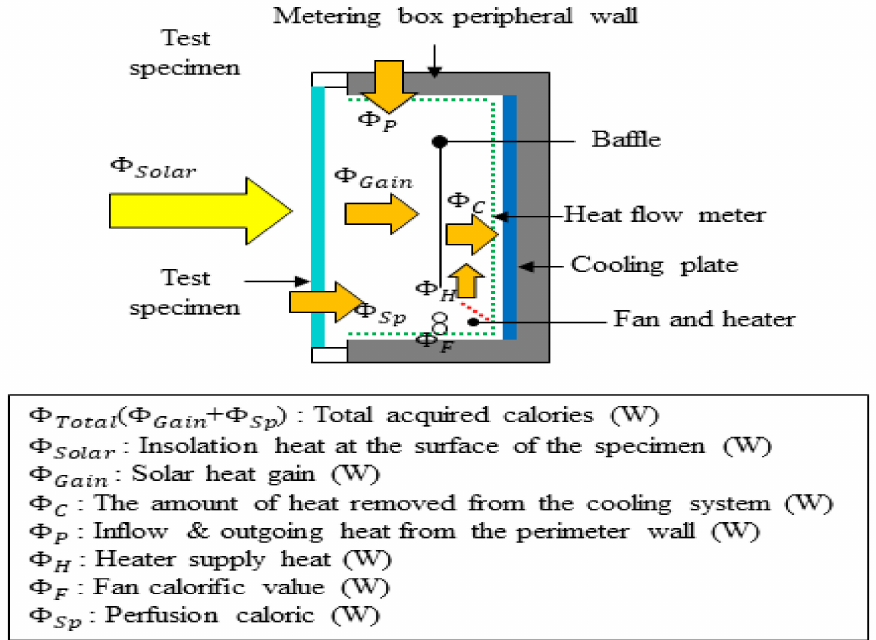
Figure 2. Solar heat gain measurement